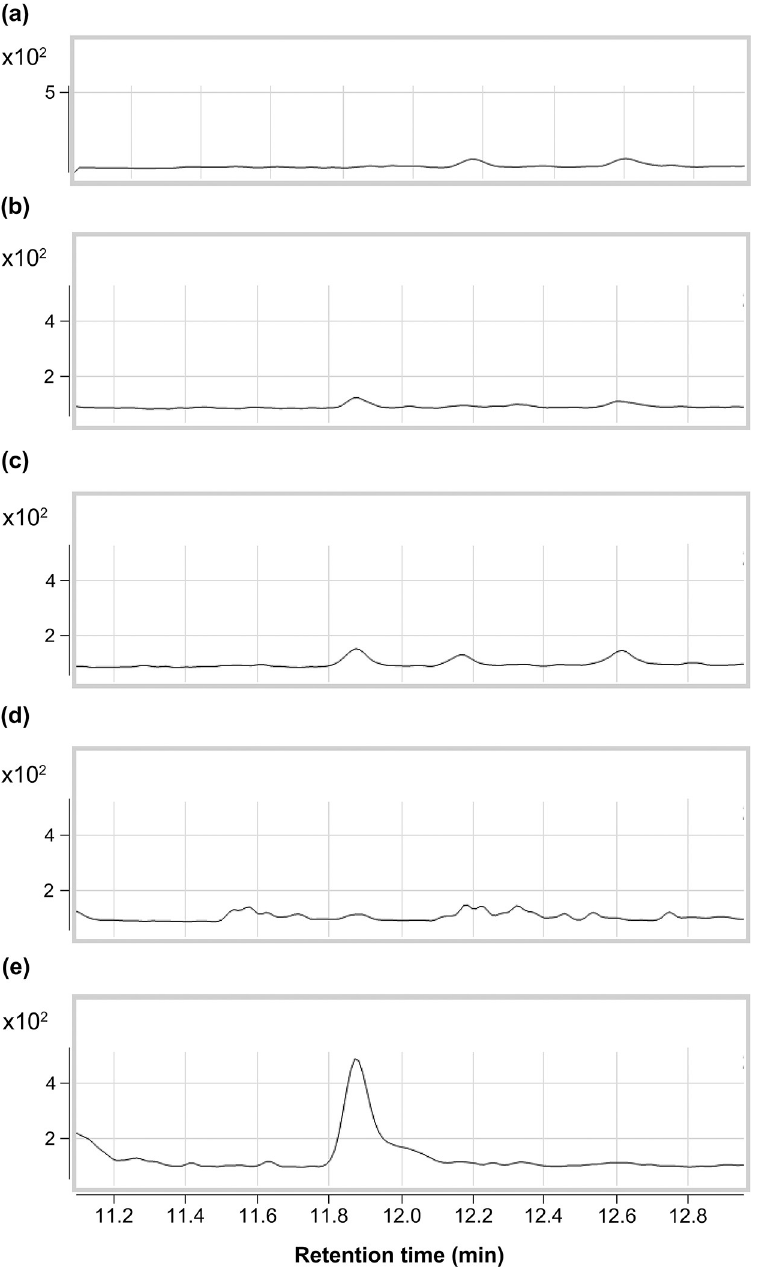
Fig 9. Selected ion monitoring (SIM) chromatograms according to allyl mercaptan (AM) ( m/z 74). The peak in each skin-gas sample collected during the stress interview (b, c) was detected at the same RT as that of AM, and the peak intensity of the skin-gas was higher than 2.5 ng/L and lower than 12.5 ng/L. (a): The control skin-gas without the characteristic odor representative of skin-gas with the characteristic odor; (b),(c): collected during the stress interview (panels #1 and #2), (d): Nitrogen gas containing AM (2.5 ng/L); (e): Nitrogen gas containing AM (12.5 ng/L). (20 min), all skin-gas samples collected during the interview had a very characteristic odor, similar to stir-fried leeks. Notably, the intensity of this characteristic odor correlated positively with the rate of increase in sympathetic activity during the interviews. In another test, this phe- nomenon was also observed in men and nonJapanese individuals while in a state of tension.